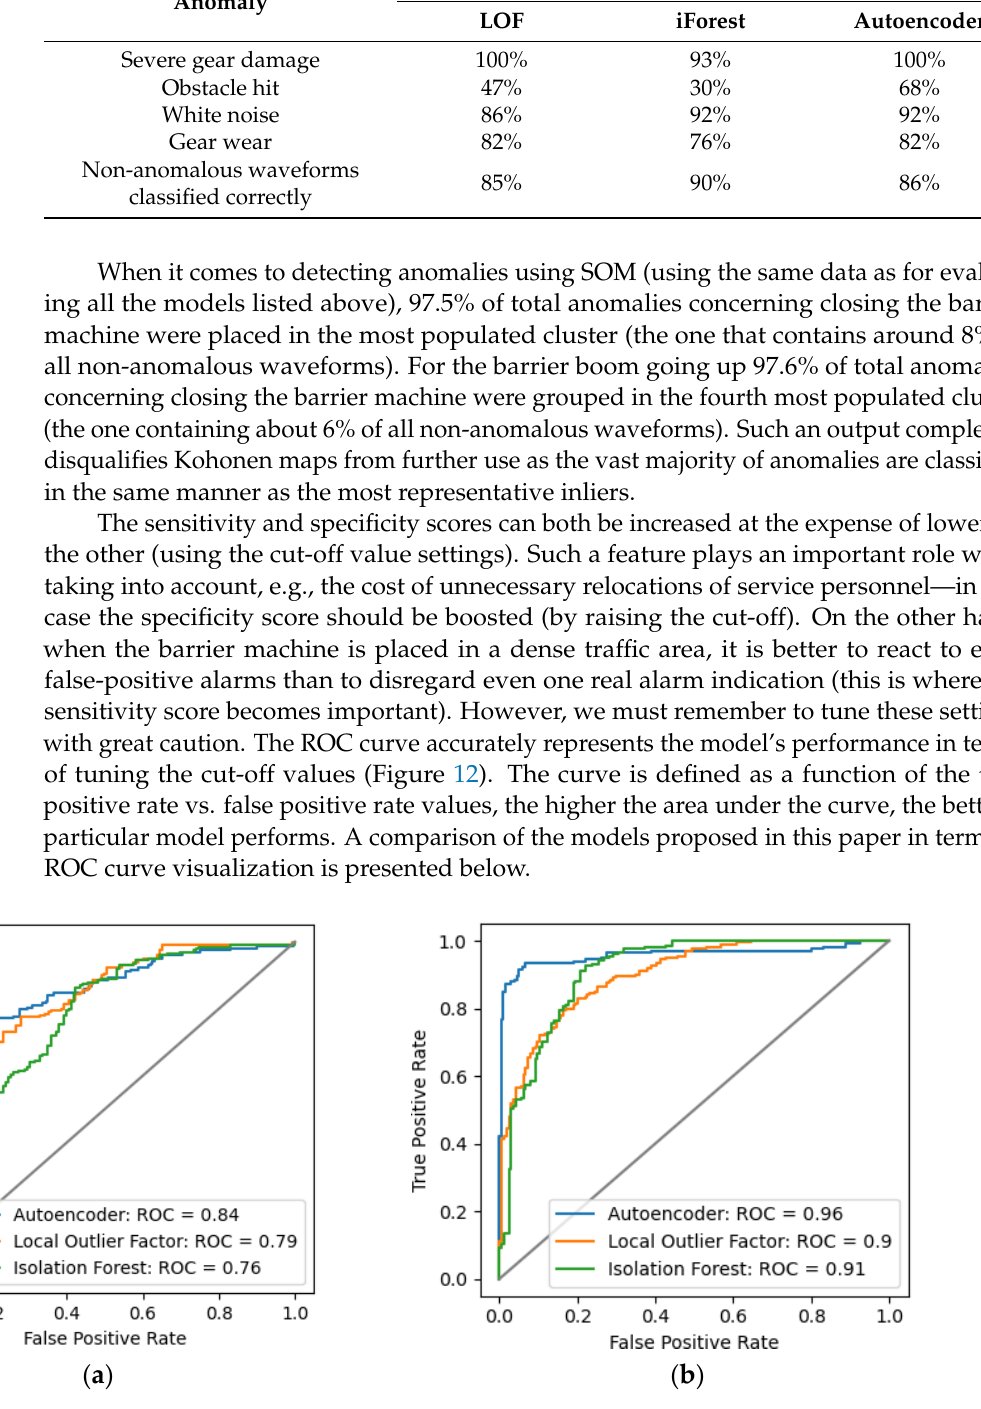
Figure 12. ( a ) ROC curves of used methods for model concerning the boom moving down ( b ) ROC curves of used methods for model concerning the boom moving up.